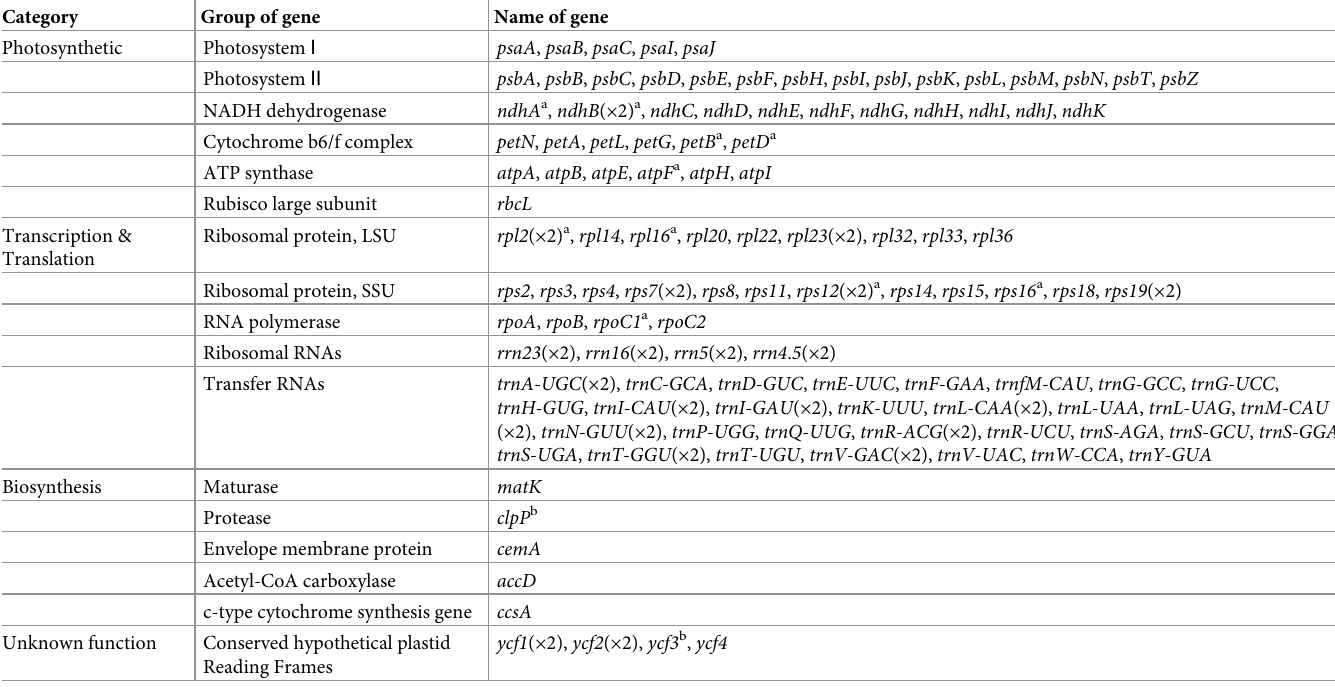
Table 2. List of genes within plastomes of the 20 subg. Cerasus species